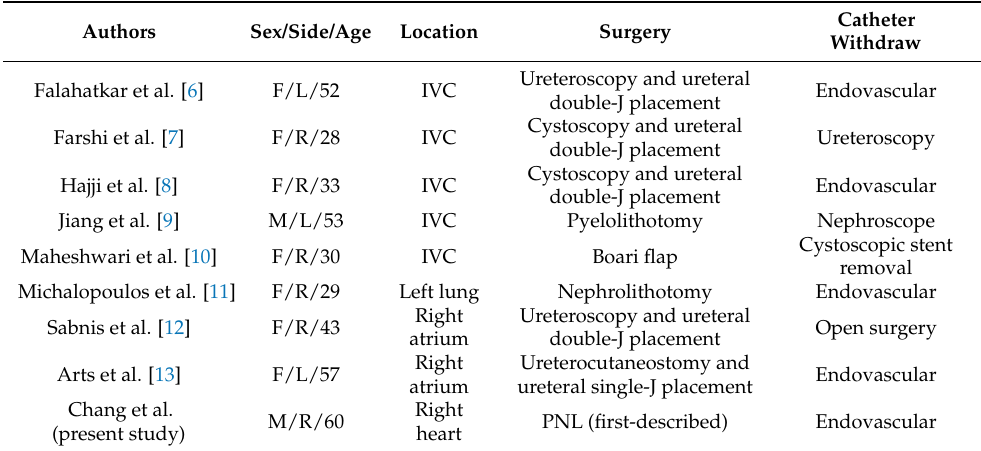
Table 1. Literature of the migration of the ureteral double-J into the cardiovascular